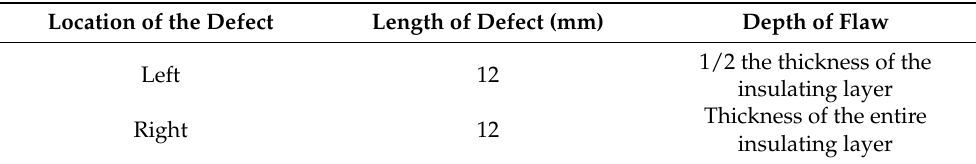
Table 5. Parameters of the defects in the insulation layer of the Group #2